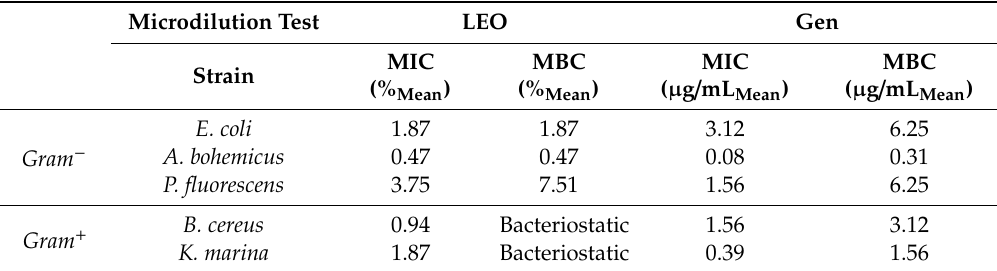
Table 4. Minimum inhibitory concentration (MIC) and Minimum bactericidal concentration (MBC) means for LEO expressed in percentage values (%) and the positive control (gentamicin) expressed in µ g / mL against the five tested bacterial